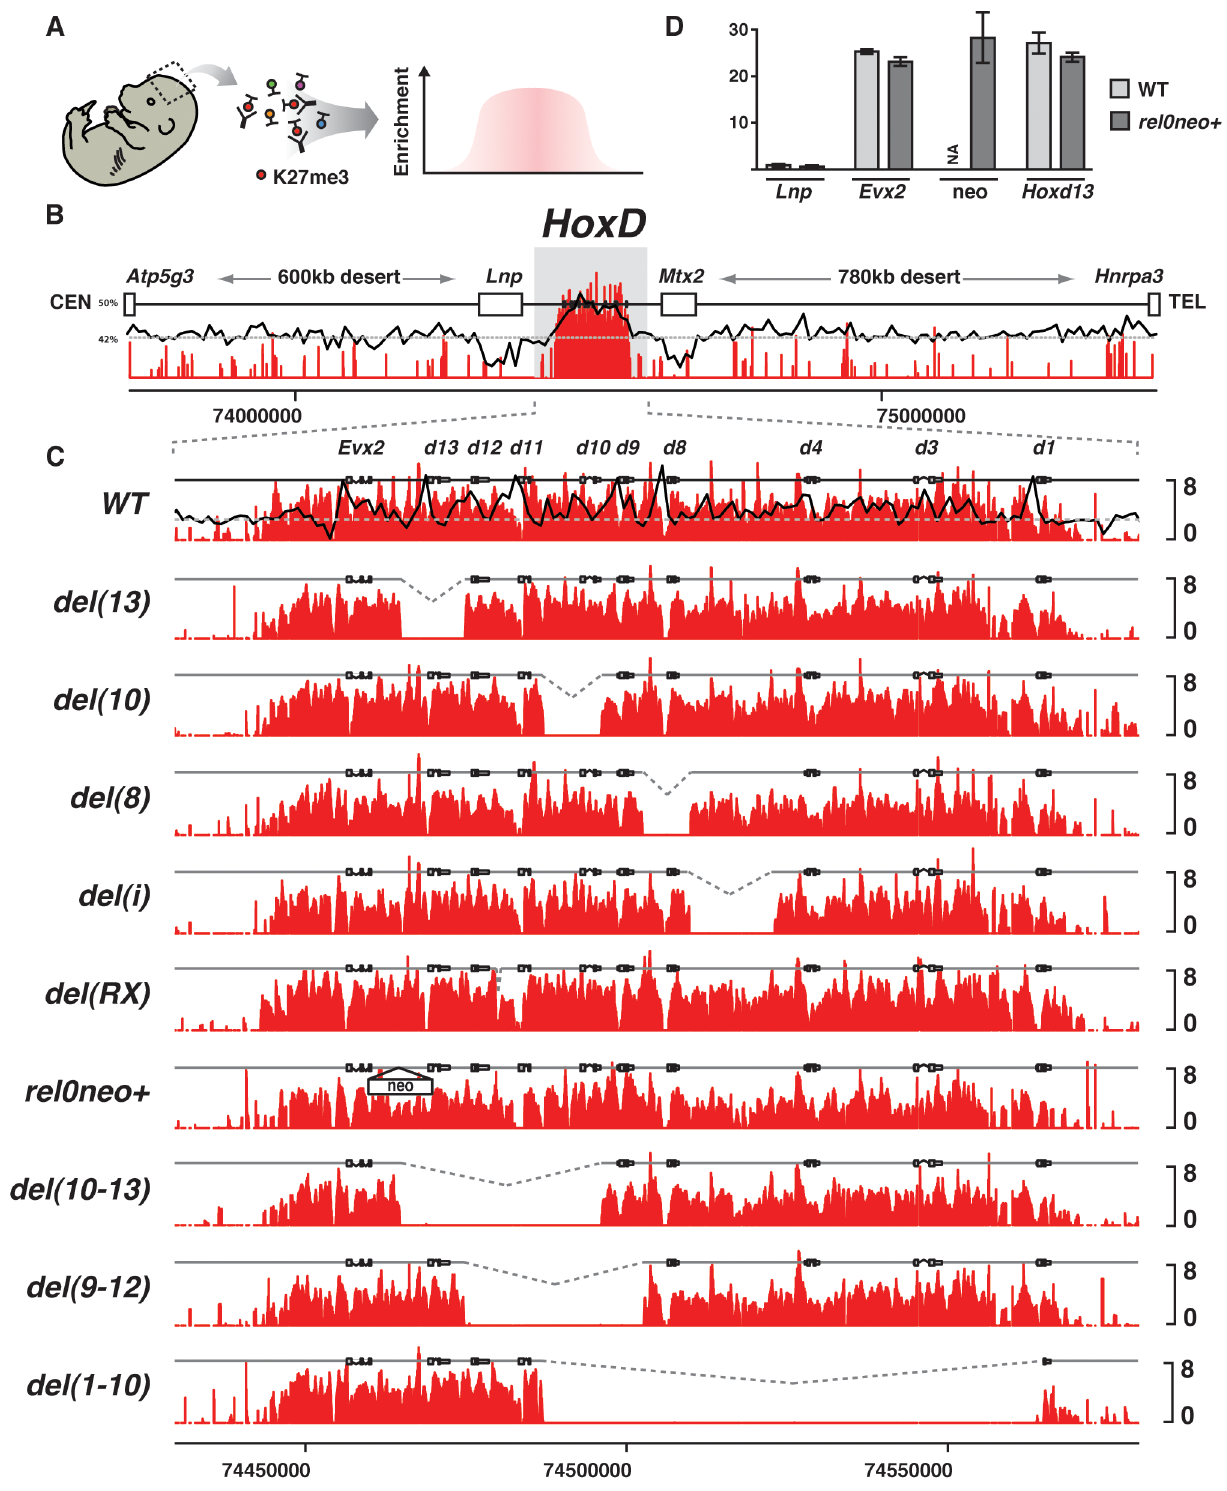
Figure 2. Effect of single Hox gene deletions on the H3K27me3 profiles. (A) Schematics of the procedure whereby E13.5 embryonic forebrains are used to ChIP H3K27me3. (B) Wild type genomic landscape of the murine HoxD cluster flanked by two large gene deserts on its centromeric (CEN) and telomeric (TEL) sides. The log2 profiles of H3K27me3 enrichment obtained on tiling arrays (red) and GC density using a 10 kb sliding window (black). Dotted grey line corresponds to the average GC content of the mouse genome (42%). (C) H3K27me3 (red) profiles of wild type and various deleted alleles. Genotypes are specified on the left with the extent of the deletion schematized by the dotted lines. GC density using a 1 kb sliding window is depicted in the upper most panel (black line). (D) Comparison between the H3K27me3 profiles of wild type and rel0neo + animals as measured by qRT-PCR.